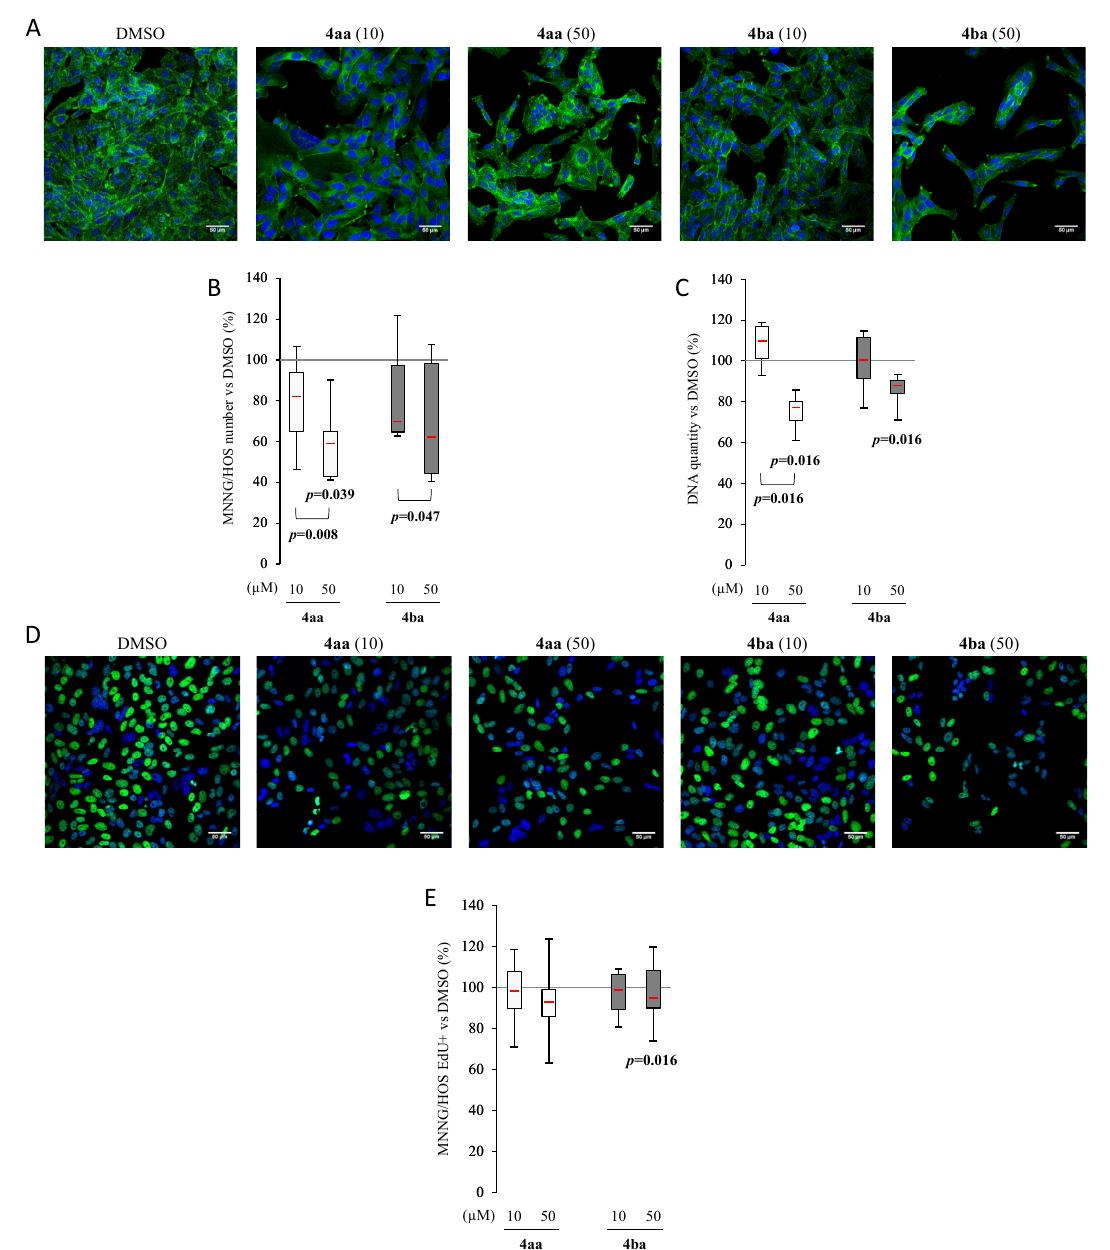
Figure 4. Pyridazinone scaffold-based molecules decrease MNNG/HOS proliferation. Representative confocal images of cell morphology using confocal LSM 710 NLO Zeiss. Cytoskeleton was stained with Phalloidin/Alexafluor TM 488 (green) and nuclei with DAPI (blue) ( A ). Scale bar = 50 µm. MNNG/HOS number variation versus DMSO with cell count per field ( B ) and DNA quantification ( C ). Representative confocal images of cell proliferation with EdU stained (green) and nuclei stained with DAPI (blue) ( D ). Scale bar = 50 µm. Quantification of EdU positive cells versus DMSO ( E ). n = 7, min 8 cells per field, randomly chosen, 5 fields per condition. p -values are given relative to DMSO on box-plots; the brackets indicate the conditions compared.